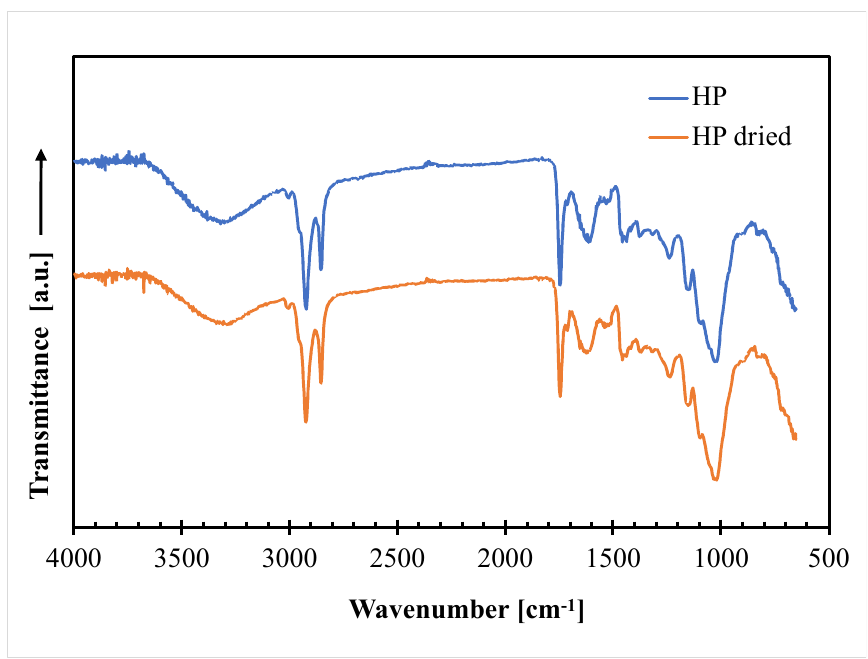
Figure 3. ATR − FTIR curves of not dried (HP) and dried (HP dried) hazelnut perisperm samples.